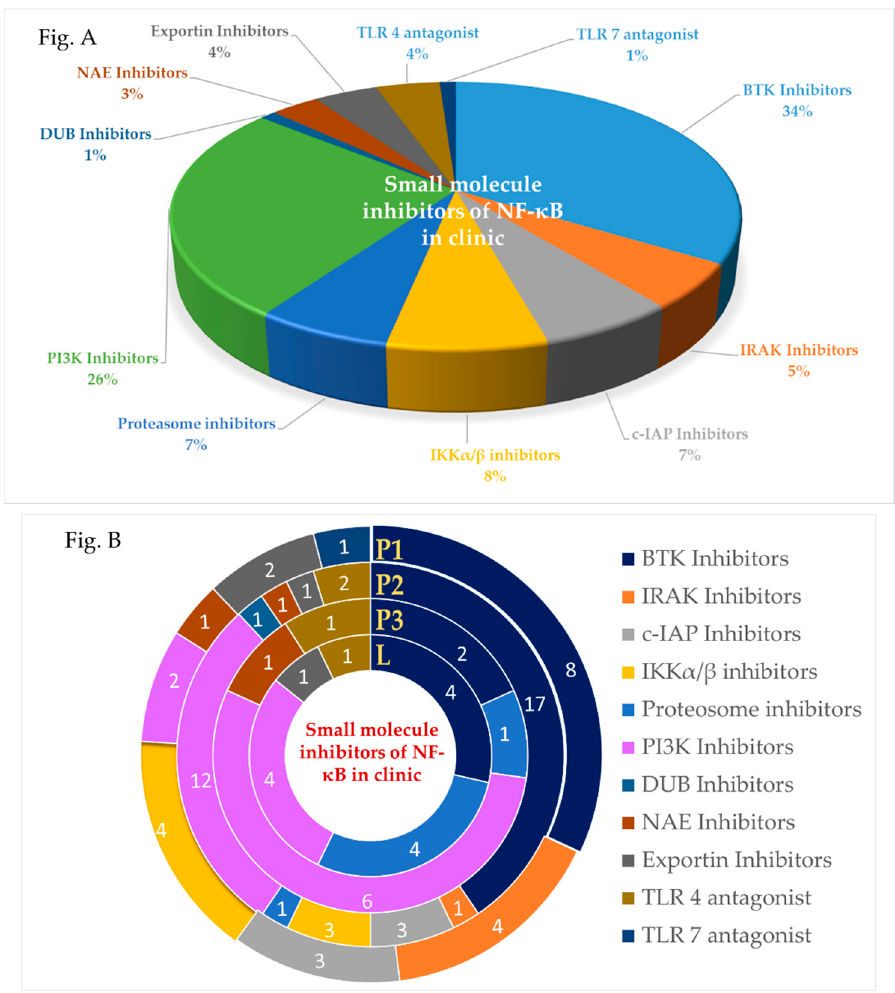
Figure 4. ( A ) Percentage distribution of small molecule inhibitors from various targets in NF- κ B pathways reached in the clinic for different indications. ( B ) Similarly, the number of small molecule inhibitors from various targets in NF- κ B pathways placed in phase 1(P1), phase 2(P2), phase 3(P3), and launched (L) in clinical trials.